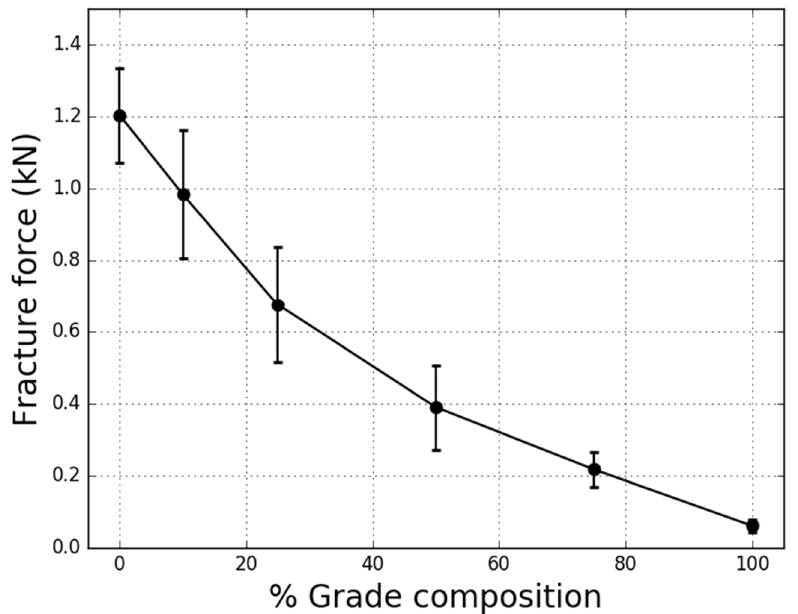
Figure 17. Variation of peak fracture force versus mineral grade.